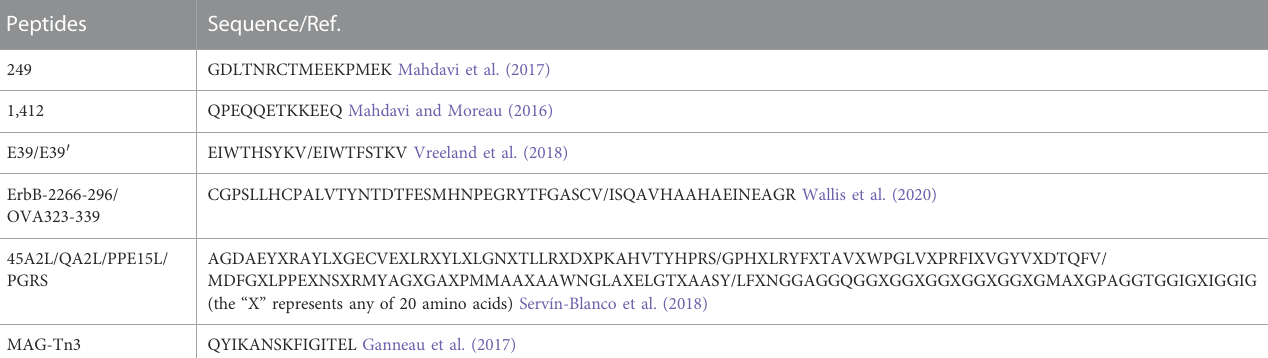
TABLE 4 Summary of the major peptide-based vaccines at early stage research for breast cancer therapy. Peptides Sequence/Ref.